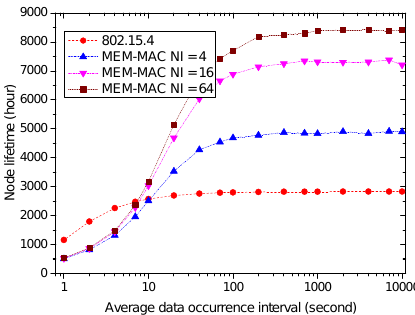
Figure 17. The node lifetime comparison of MEM-MAC and